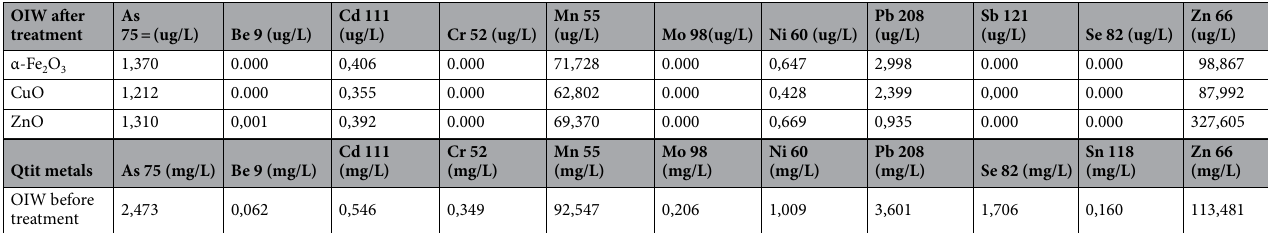
Table 4. Results of analysis by ICP-MS of the reservoir oily water (OIW) before treatment and after.